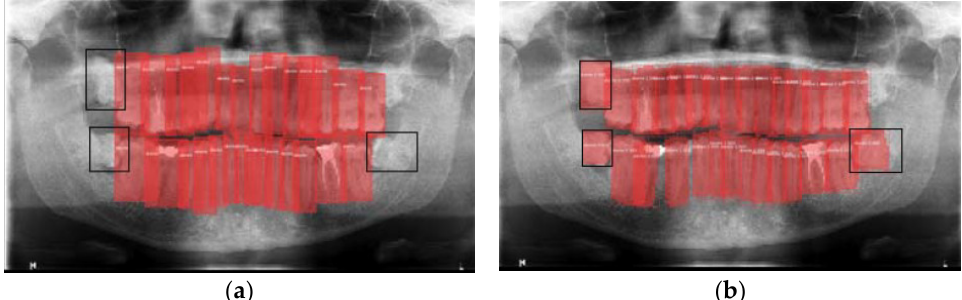
Figure 8. False positives: ( a ) Image categorization; ( b ) Bounding boxes detected by the model.